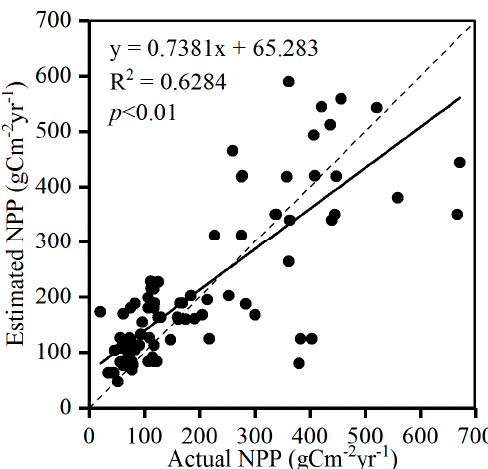
Figure 3. Accuracy assessment of simulation value of CASA model.